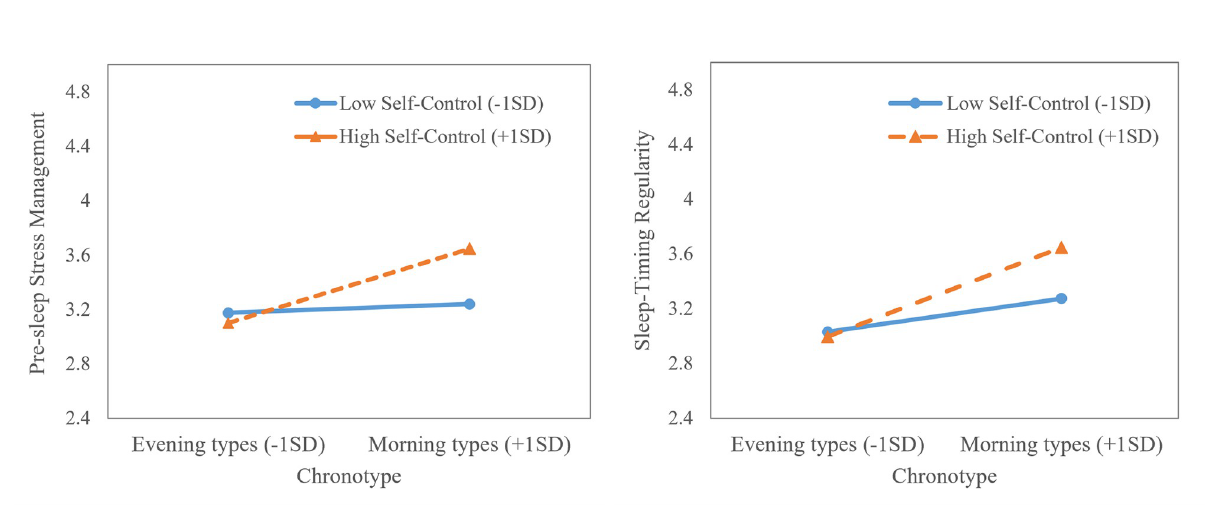
Fig 3. Pre-sleep stress management and sleep timing regularity as a function of chronotype and trait self-control. The interactions were probed at high (1SD above the mean) and low levels (1SD below the mean) of chronotype and trait self-control.